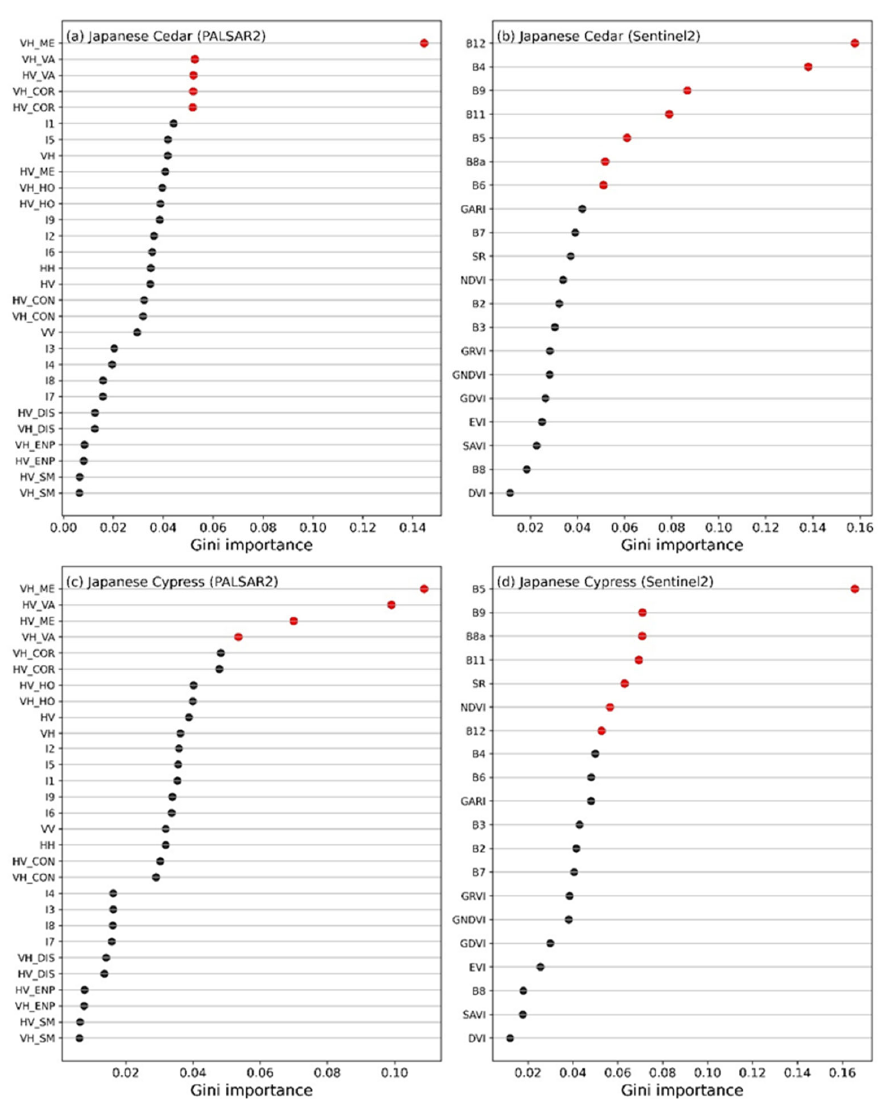
Figure 4. Variables listed in order of importance based on the mean decrease of impurity (i.e., the Gini importance). Variable names are defined in Tables 3 and 4. Red points show the relatively effective variables.